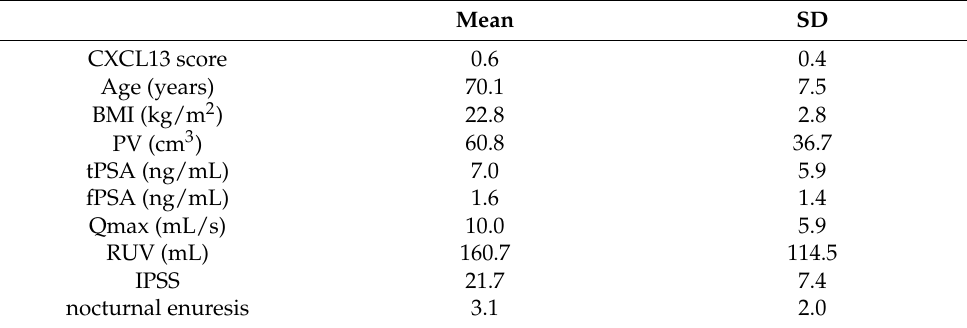
Table 3. The correlations between clinical parameters and CXCL13 expression of BPH